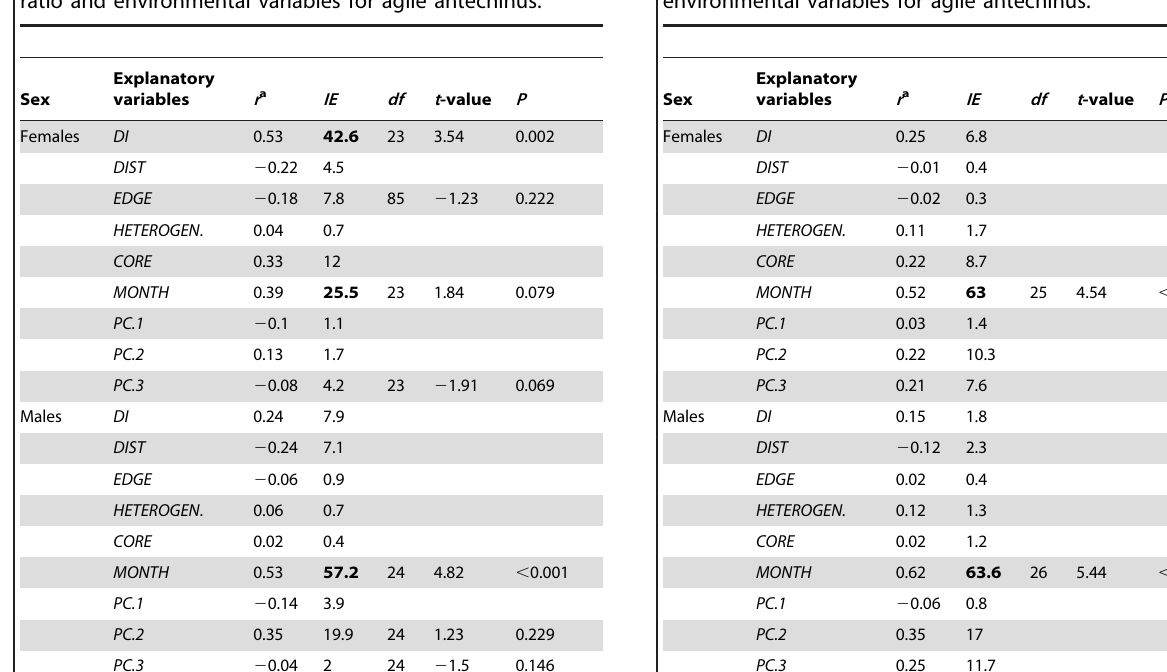
Table 9. Relationships between (log)Neutrophil:Lymphocyte ratio and environmental variables for agile antechinus.